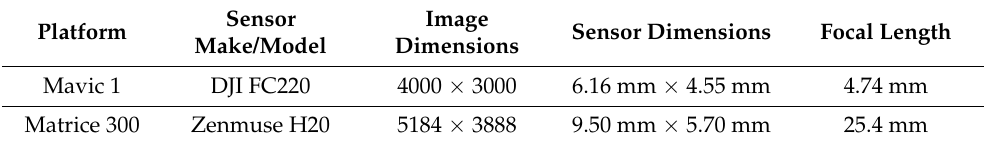
Table 2. Sensor specifications by sUAS platform type.